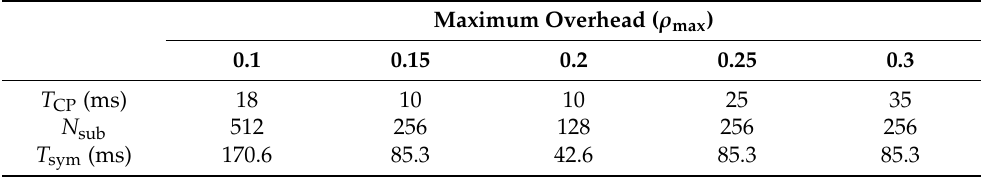
Table 7. Optimization parameters considering the KAU1 channel.